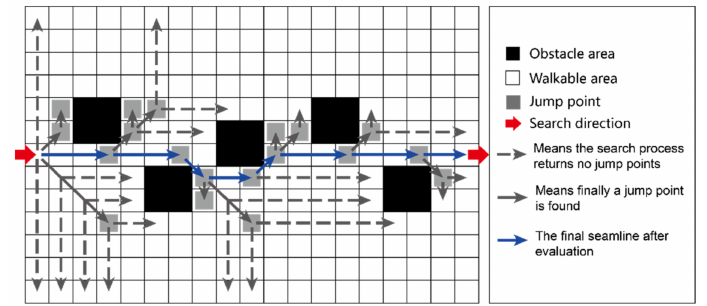
Figure 8. An illustration of JPS algorithm for detecting the seamline.